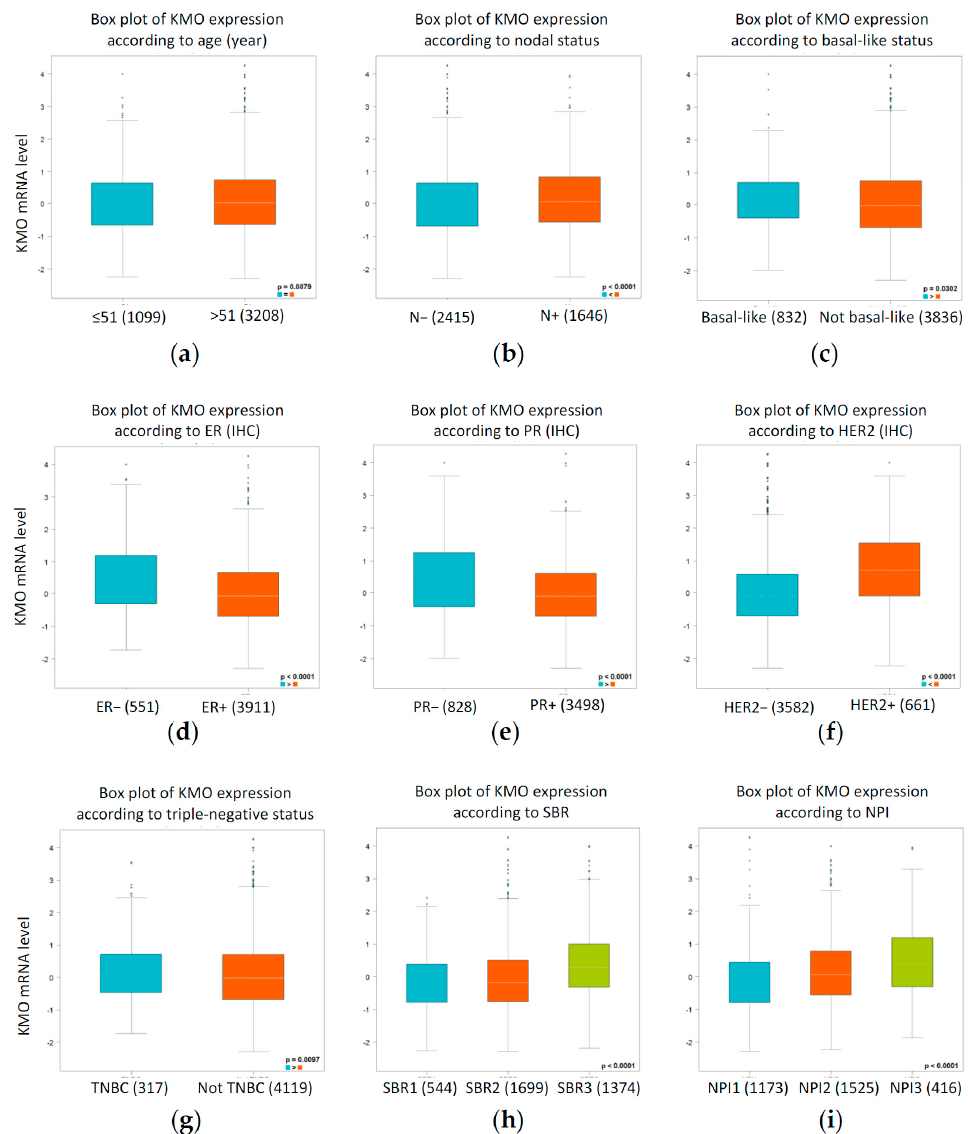
Figure 3. The relation between the KMO mRNA expression level and clinicopathological parameters in patients with breast cancer using the bc-GenExMiner 4.4. Association between KMO mRNA expression and ( a ) age ( ≤ 51 and ≥ 51 years); ( b ) nodal status (N+ vs. N − ); ( c ) basal-like subtype; ( d ) ER status (ER+ vs. ER − ); ( e ) PR status (PR+ vs. PR − ); ( f ) HER2 status (HER2+ vs. HER2 − ); ( g ) triple-negative status (TNBC vs. not TNBC); ( h ) SBR grade (SBR1, SBR2 and SBR3); and ( i ) NPI grade (NPI1, NPI2 and NPI3). (ER, estrogen receptor; HER2, human epidermal growth factor receptor 2; IHC, immunohistochemistry; NPI, Nottingham prognostic index; NS, not significant; SBR, Scarff–Bloom–Richardson; TNBC, triple-negative breast cancer.).